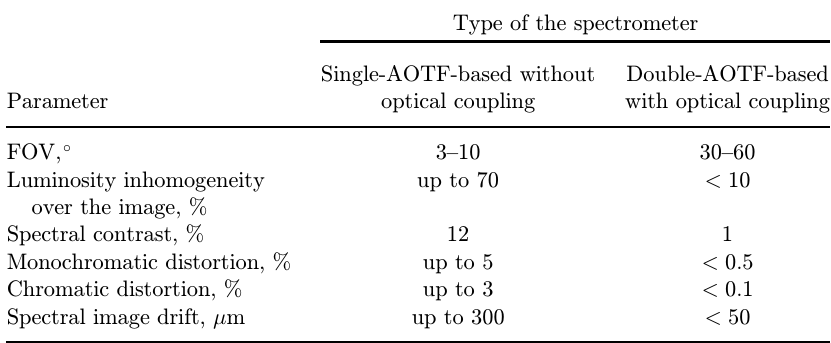
Table 1. Comparison of the described and conventional